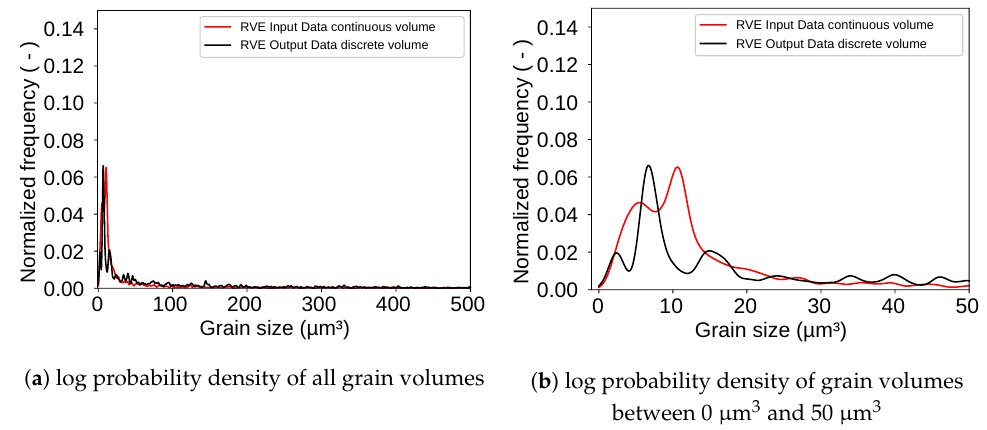
Figure 10. Log probability density of grain volumes shows that most grain volumes are in the range between 0 µ m 3 and 50 µ m 3 .